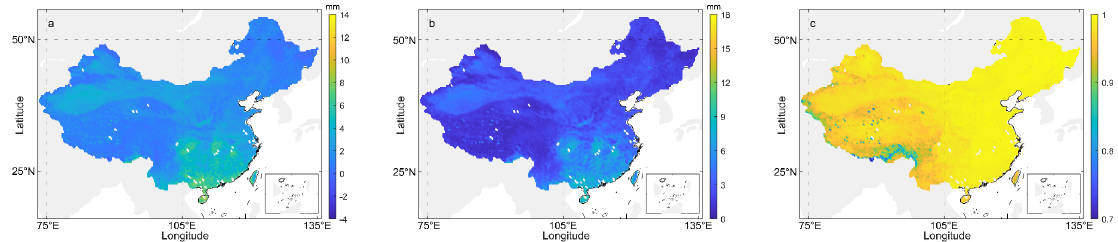
Figure 8. ( a ) Bias, ( b ) RMS, and ( c ) correlation coefficient between ERA-PWV and MOD-NIR-PWV in the six-year period from 2013 to 2018 over each grid point.